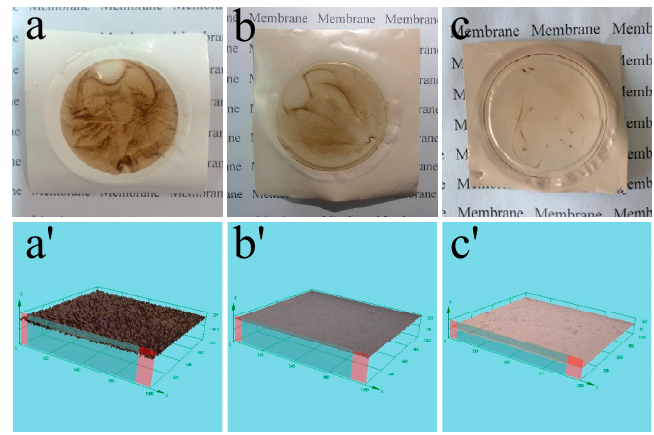
Figure 13. Digital photographs of the PSf / PES ( a ), PSf / PES-AM ( b ), and PSf / PES-AM-VT 1.0 ( c ) membranes surfaces after two cycles of HA solution filtration. Confocal laser scanning microscopy images of the PSf / PES ( a’ ), PSf / PES-AM ( b’ ), and PSf / PES-AM-VT 1.0 ( c’ ) membranes surfaces after two cycles of HA solution filtration